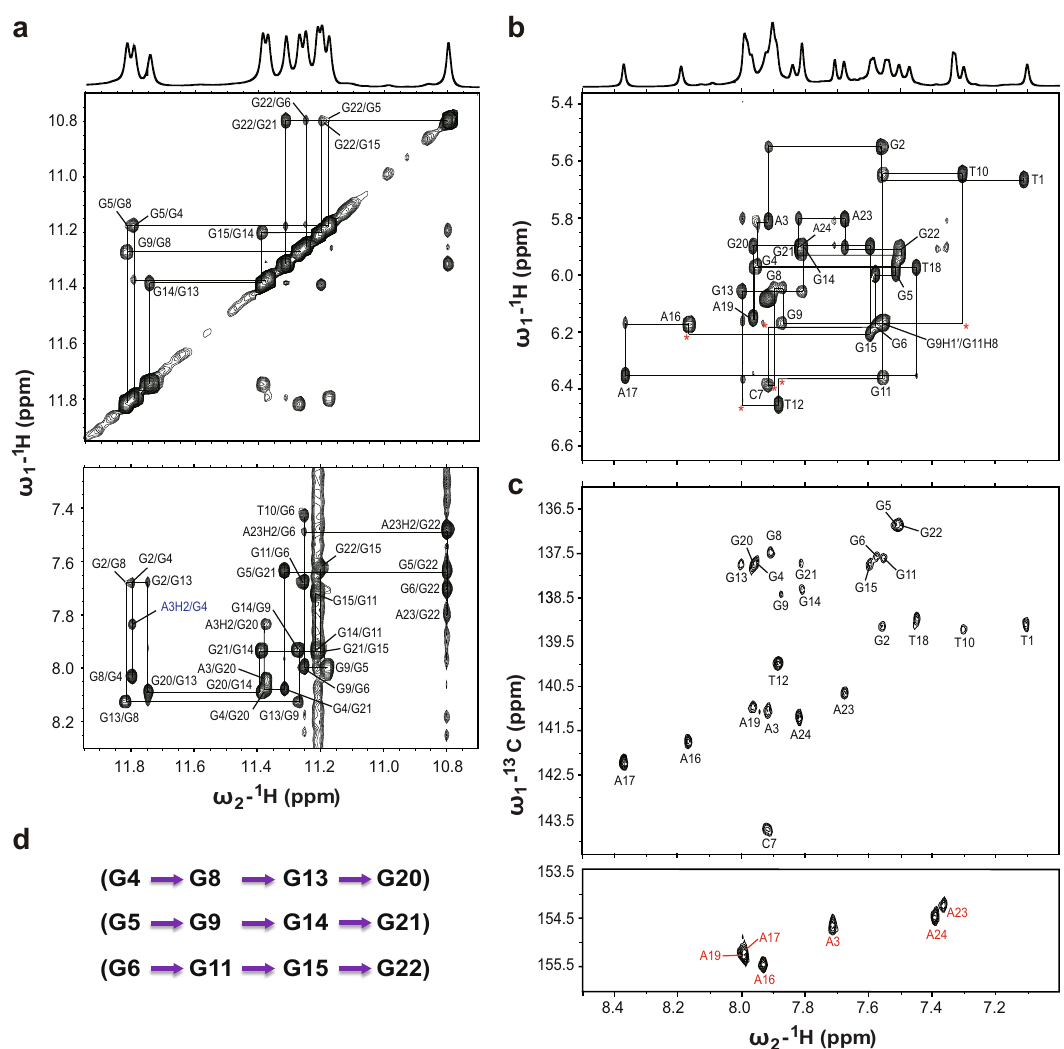
Fig.3|2DNMRspectraofthefree KRAS -G4.a TheH1 – H1andH1 – H8regions,and b H1 ′ -H6/H8 region from the 2D-NOESY spectra of Pu24m1 DNA in H 2 O with sequential assignment pathway. Missing connectivity is marked with red asterisks. The cross-peak assigned to the minor species is labeled in blue. c H6 − C6/H8 − C8